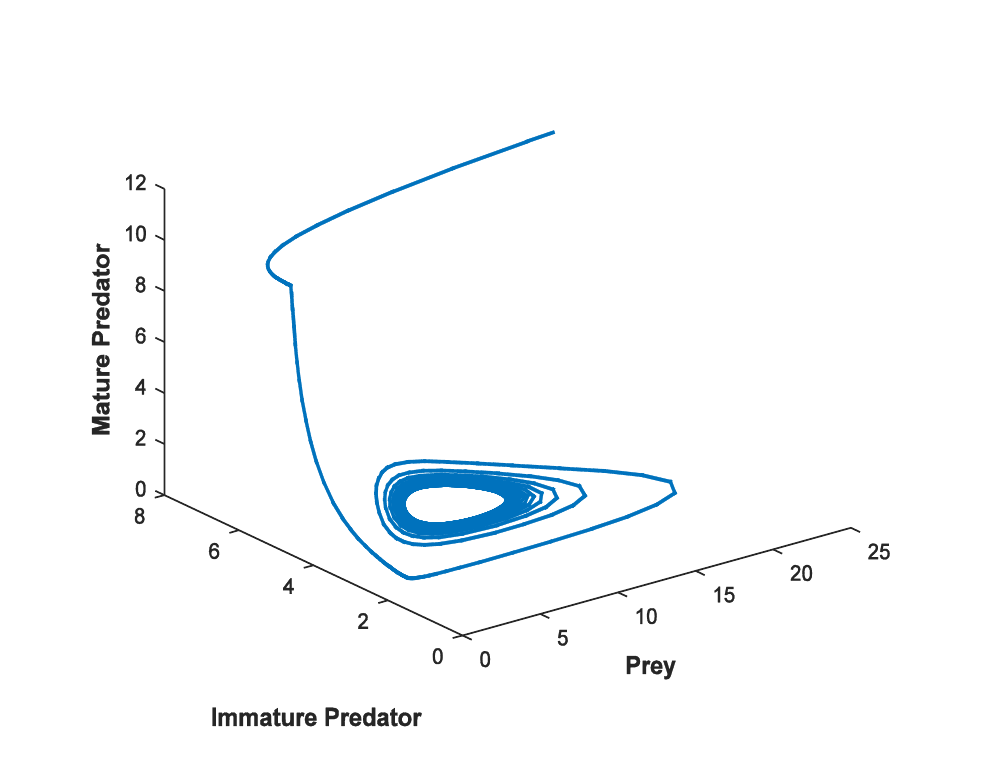
Figure 6. Phase portrait for T=2.5.